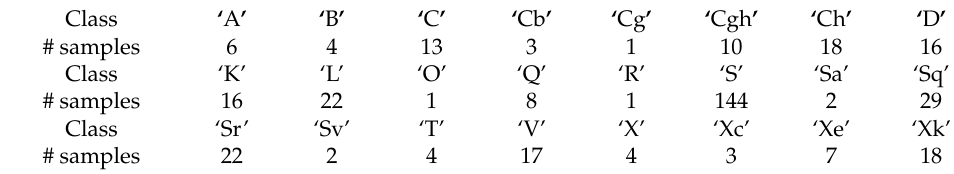
Table 1. Description of the asteroid spectral datasets for 371 asteroids with 24